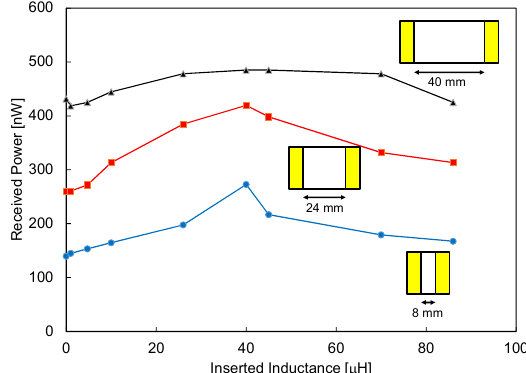
Figure 7. Relationship between inserted inductance and received power.